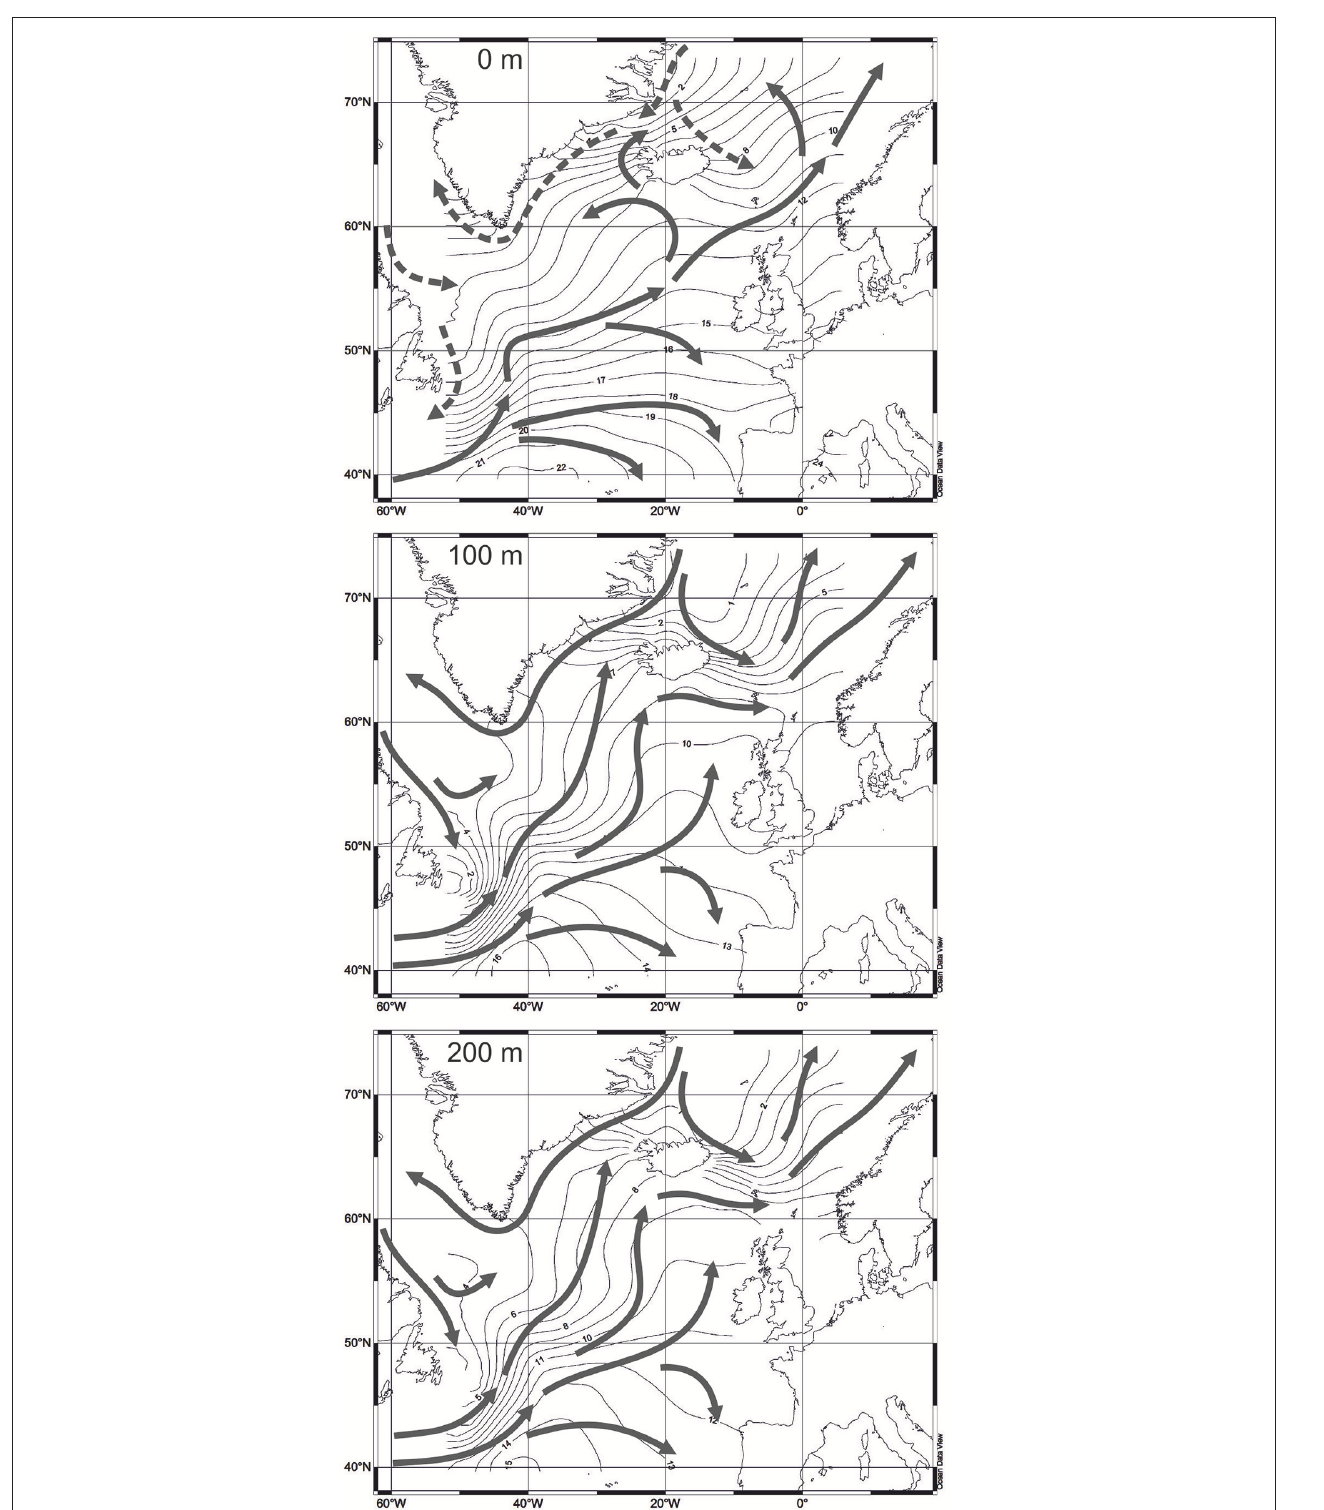
FIGURE 3 | Water temperature, averaged for 1955-1964 (Locarnini et al., 2013). Water circulation on different depths according to Gorshkov et al. (1977): solid arrows for 0 m—warm currents, dashed arrows for 0 m—cold currents, solid arrows for 100 and 200 m—directions of water circulation.